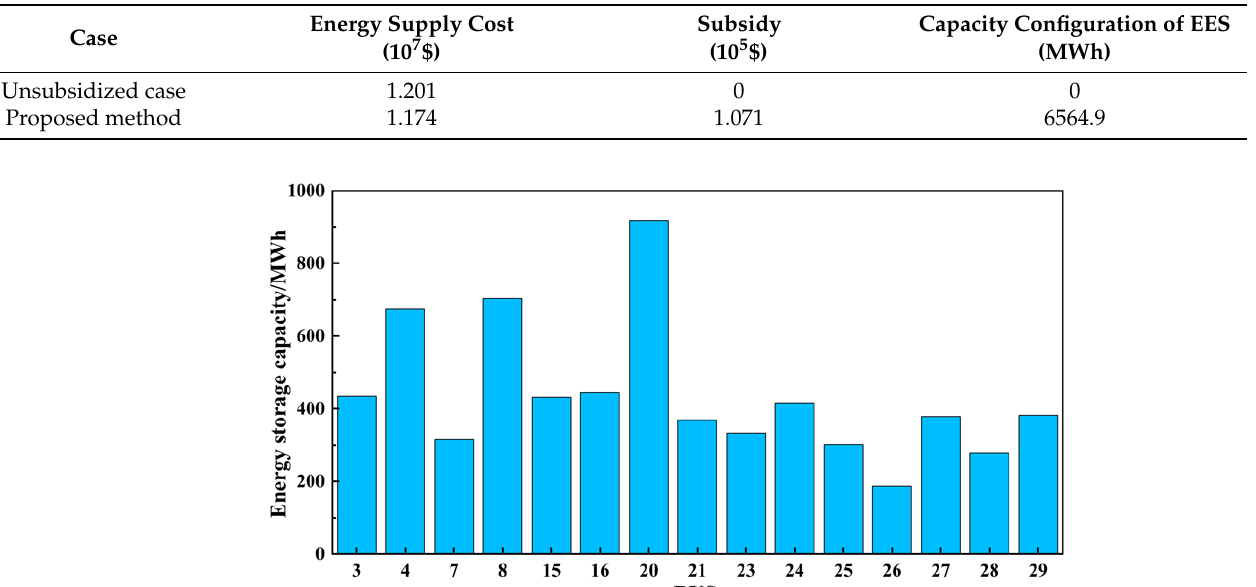
Figure 8. EES capacity configuration after the EES configuration.